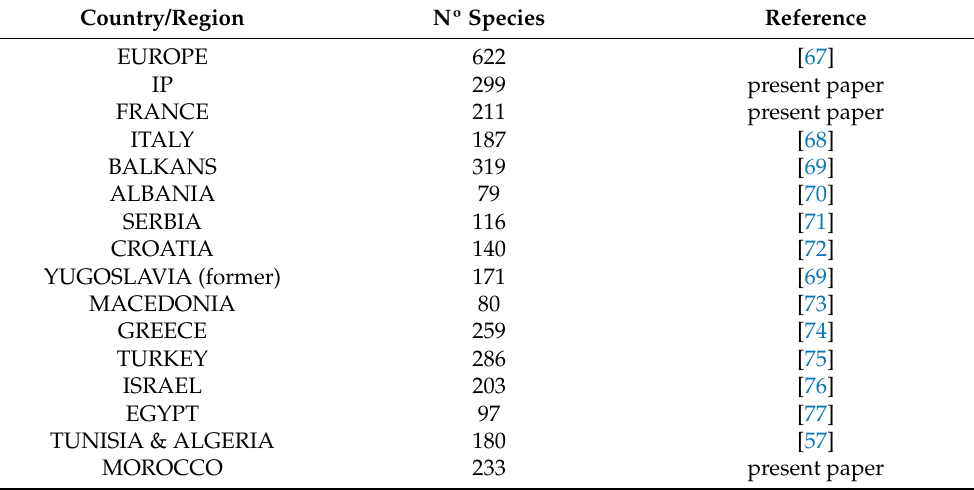
Table 1. List of Mediterranean countries and number of cited species.